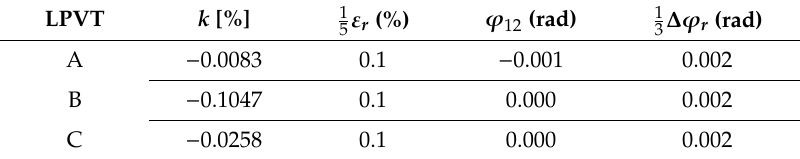
Table 2. Results of the application of Equations (3) and (4) for the test vs. electric field. LPVT